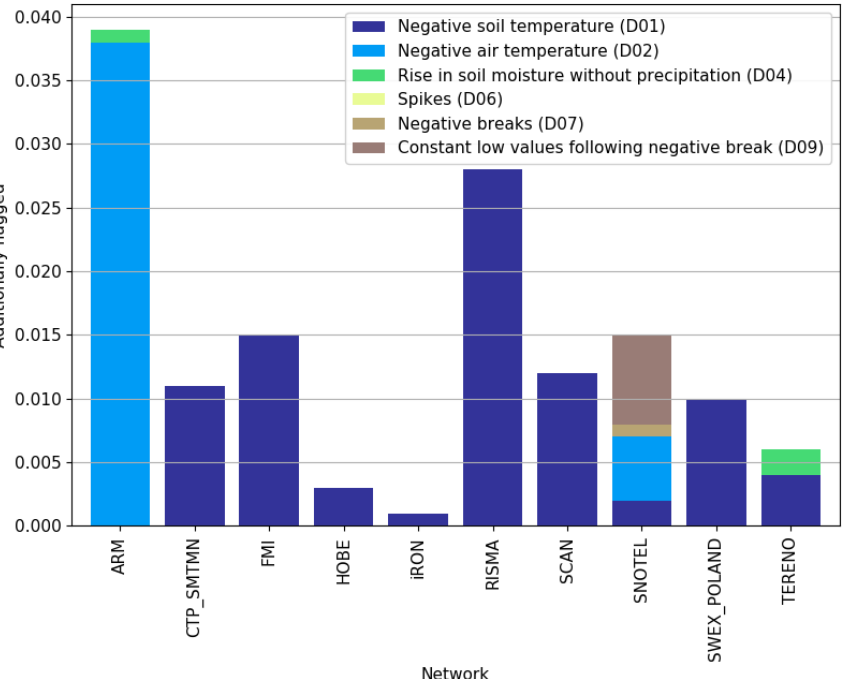
Figure 4. Additionally flagged observations by the network shown as fraction of total number of observations. Note that, in principle, the cumulative sum of fractions can be > 1 as the occurrence of each flag ranges between 0 and